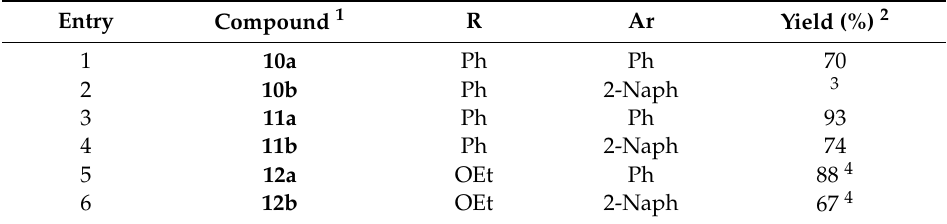
Table 2. Aziridines 10 and allyl α -aminophosphine oxides and phosphonates 11 and 12 obtained. Entry Compound